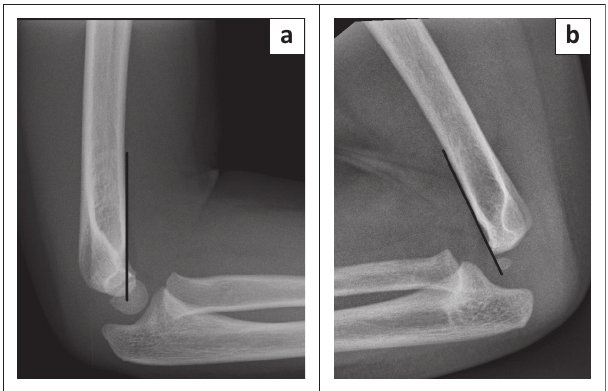
FIGURE 4: (a) Normal anterior humeral line in a 4 year old passes through the middle third of the capitellum (black line). (b) Anterior humeral line in a 6 month old child with will not pass through the middle third of the partially ossified capitellum (black line).